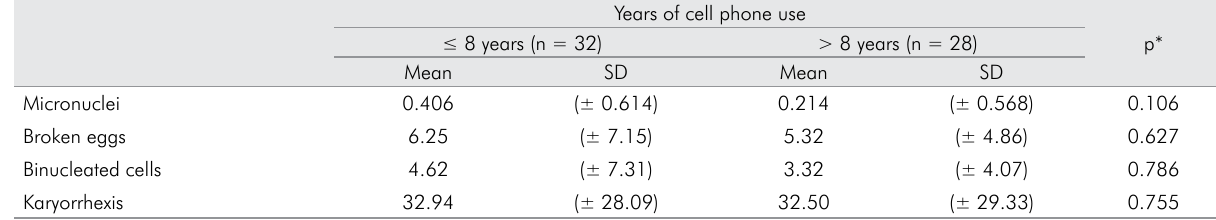
Table 4. Comparison of years of cell phone use and mean values of nuclear changes within the whole oral mucosa (3,000